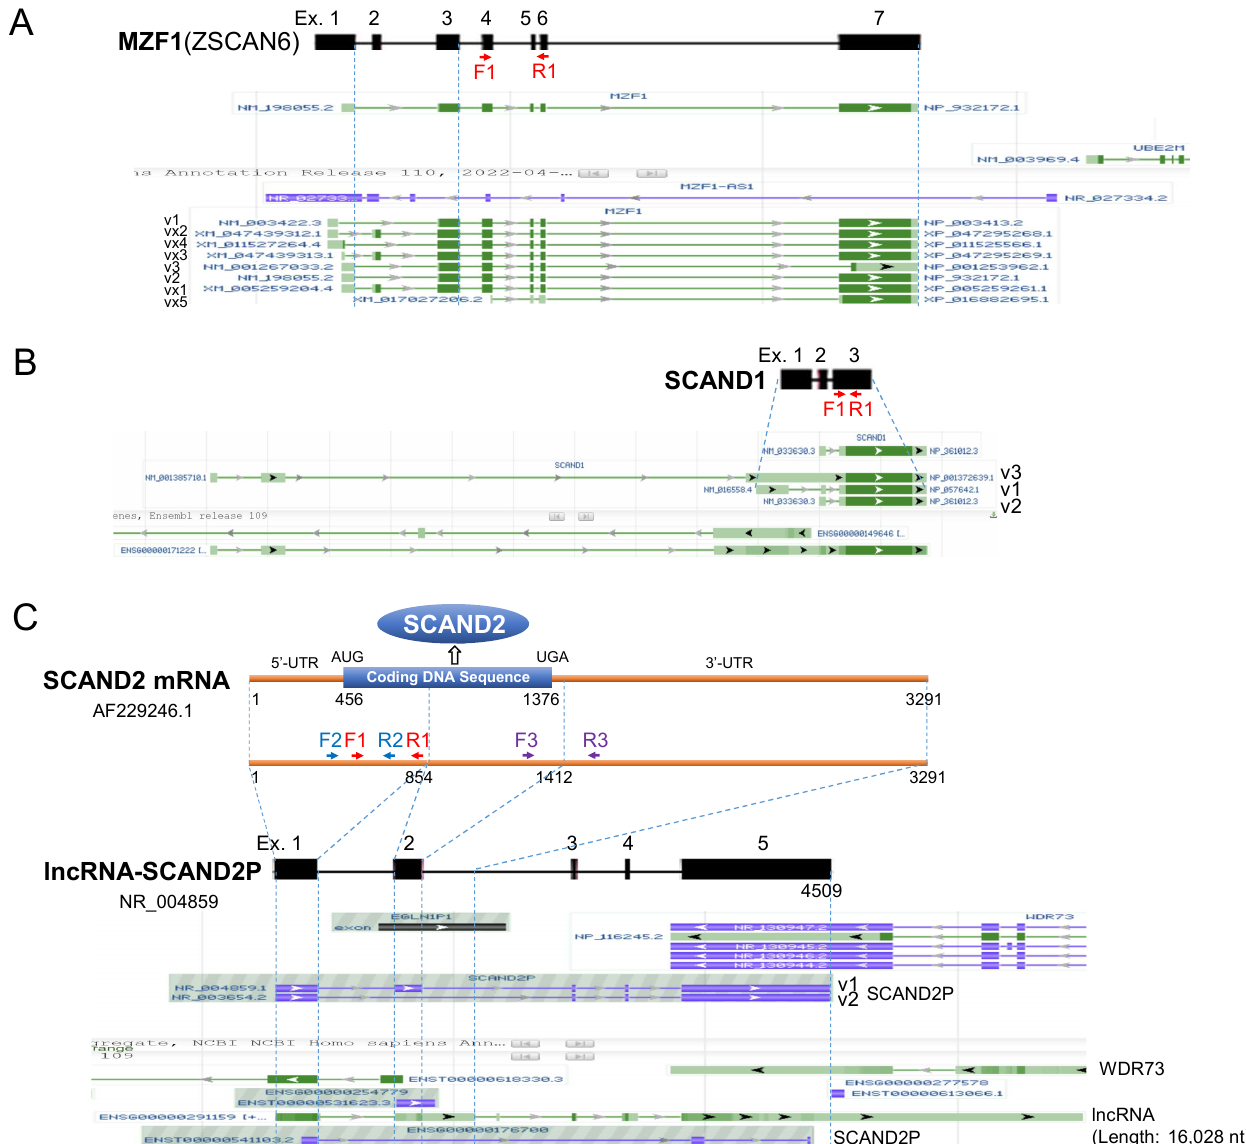
Figure 2. Alternative splicing variants and primer mapping of ( A ) MZF1(ZSCAN6) , ( B ) SCAND1 , and ( C ) SCAND2 genes. Complete coding DNA sequence (CDS) of SCAND2 mRNA and lncRNA- SCAND2 overlapped in the genome. Ex., exon numbers. Primer positions were mapped, e.g., F1 and